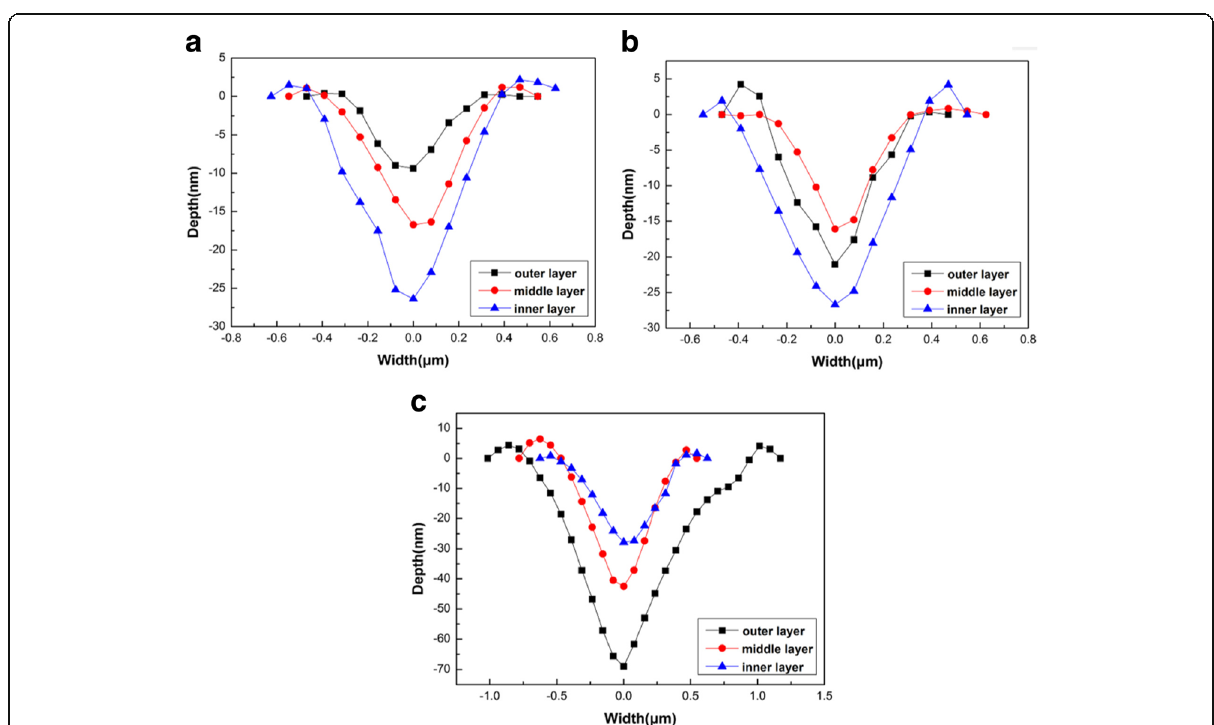
Fig. 6 Profiles of nanoscratch tracks on the enamel layers of the normal tooth, mild dental fluorosis, and severe dental fluorosis. a Normal tooth enamel. b Mild dental fluorosis enamel. c Severe dental fluorosis